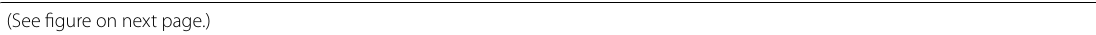
2048 pixels. The average diameter 900 pixels. b : The diffracted × = 1024 =